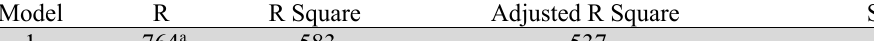
Model Summary (ROA)